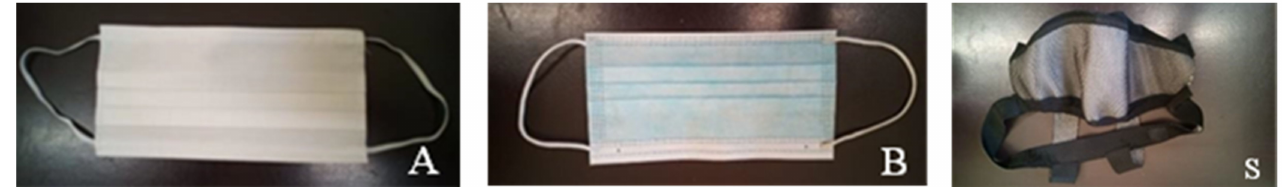
Figure 1. Face masks tested in the study: Masks ( A , B ) are two surgical masks, Mask ( S ) is an ad hoc designed mask for